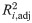
Determining timescales of the response to trends, and validation test results.A, Sample trajectories of market orders by two FTs during six minutes. Upward (downward) triangles are sell (buy) orders. The colour of triangles represents the status of market orders: orange (gray) signifying filled (missed). The black line is the trajectory of transaction prices. B, Weights wi in Eq (3) of 131 traders obtained from a logistic analysis Eq (5) are plotted at jik. To obtain the optimal wi, we follow the same procedure with the limit-order analysis except for using the SSE, not Ri,adj2. C, The horizontal and vertical axis mean the historical trends and the probabilities controlling the direction of market orders, respectively. The black is the standard logistic function. On top of that, we depict the magnitude of the historical trends for two traders as cross-marks, which is obtained by the Eq (5). The market orders issued to the buy (sell) side are depicted by the cross-marks at 1 (0).